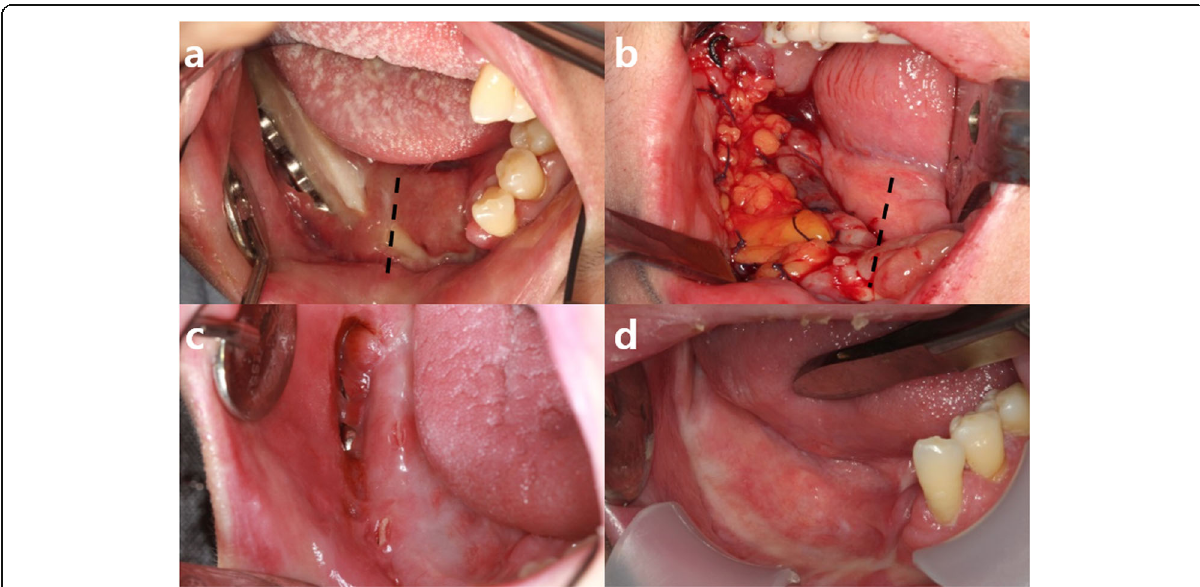
Fig. 4 a Grafted fibula bone was maintained in good condition but partial exposure of reconstruction plate and grafted bone showed from the retromolar to the premolar region (midline marked with a dotted line). b The pedicled BFP flap perfectly covered the intra-oral defect without tension, and flap was sutured to marginal oral mucosa with 3-0 black slik (midline marked with a dotted line). c Part of the metal plate was still exposed after the pedicled BFP graft, but the condition remained stable. d Re-epithelization of the grafted buccal fat pad was complete after the removal of the reconstruction metal plate (5-month